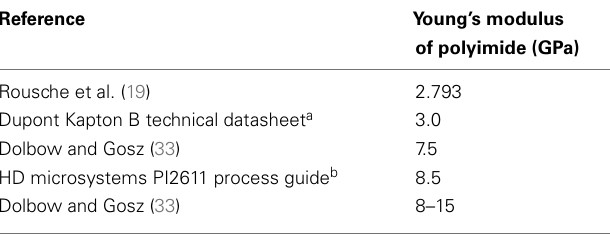
Table 2 | List ofYoung’s modulus values of polyimide obtained from